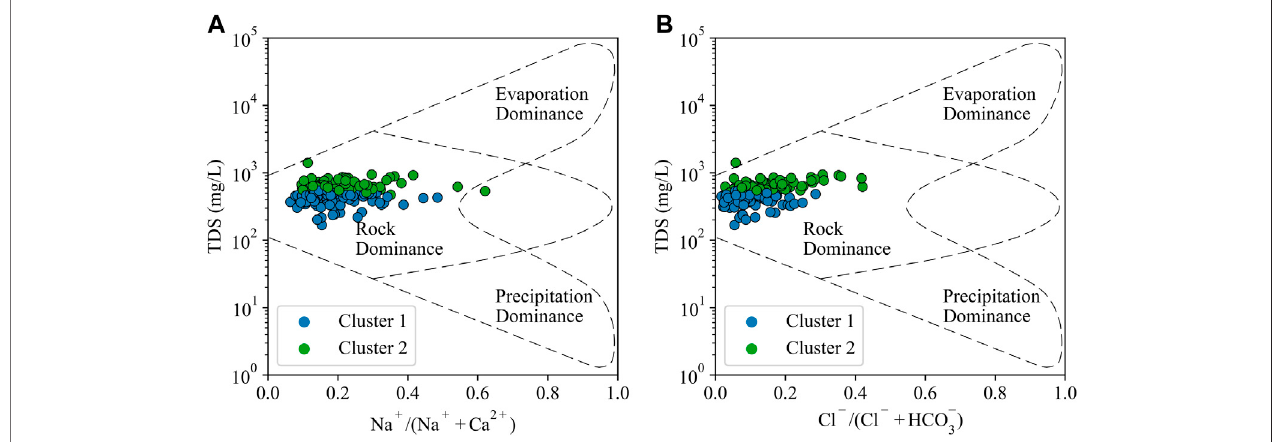
FIGURE 7 | Gibbs diagrams demonstrating the mechanisms governing groundwater chemistry. (A) TDS vs. Na + /(Na + +Ca 2+ ), (B) TDS vs. Cl − /(Cl − + HCO 3 − ).